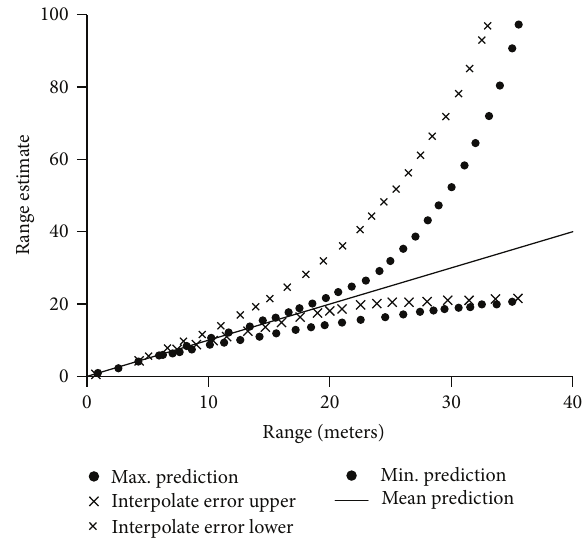
Figure 12: Range error estimates versus range for room light. The dashes show maximum and minimum predictions versus